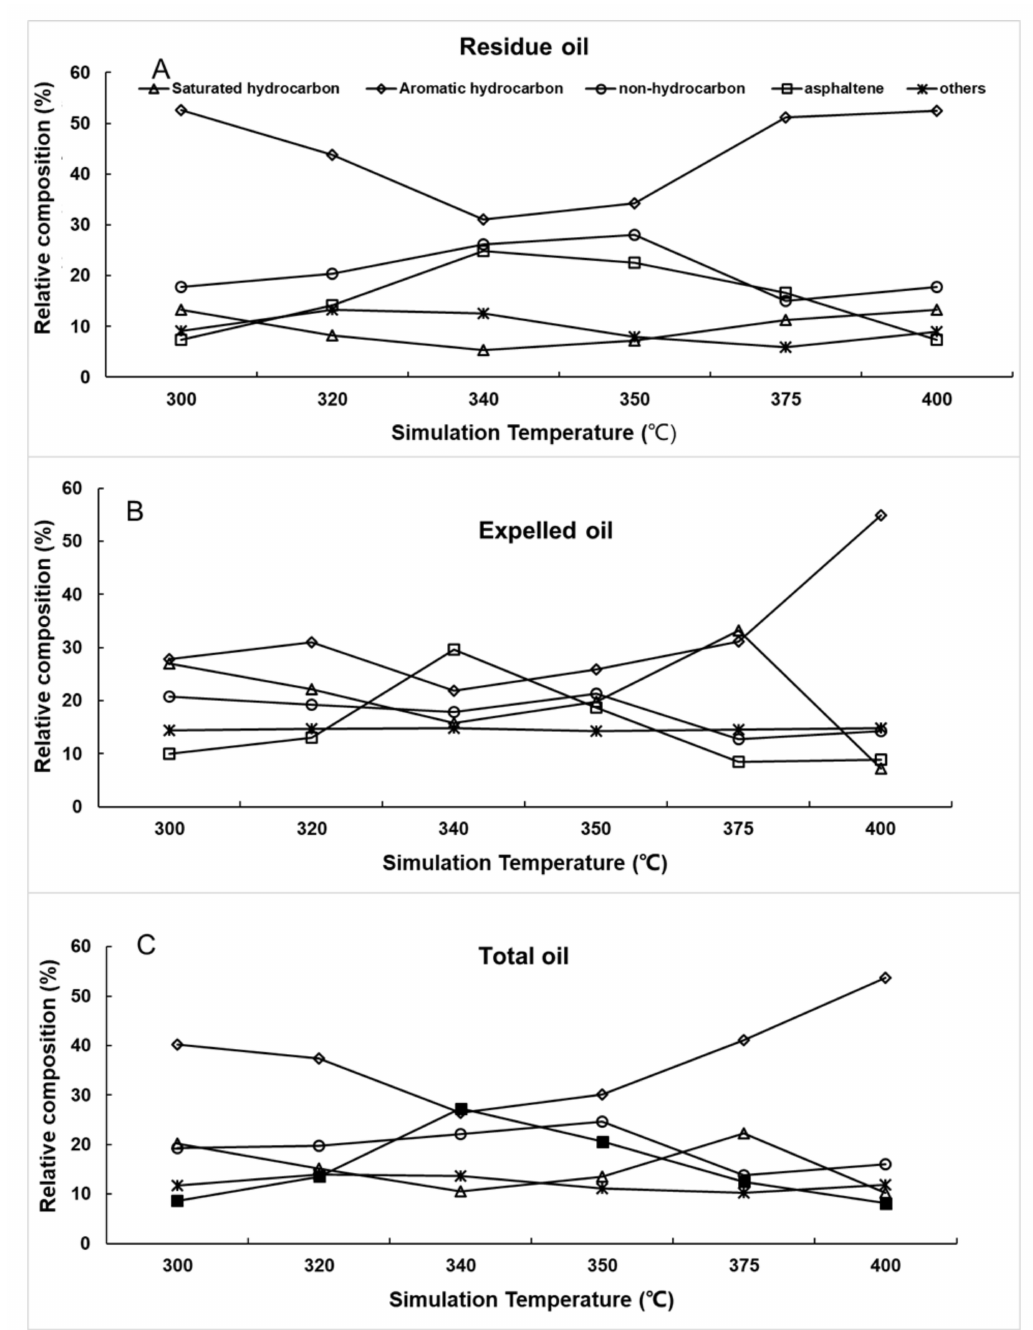
Figure 6. Relative composition of group components (saturated hydrocarbons, aromatic hydrocarbons, non-hydrocarbons, and asphaltenes) in ( A ) residual oil, ( B ) expelled oil and ( C ) total oil from artificial maturation of the Aus-2